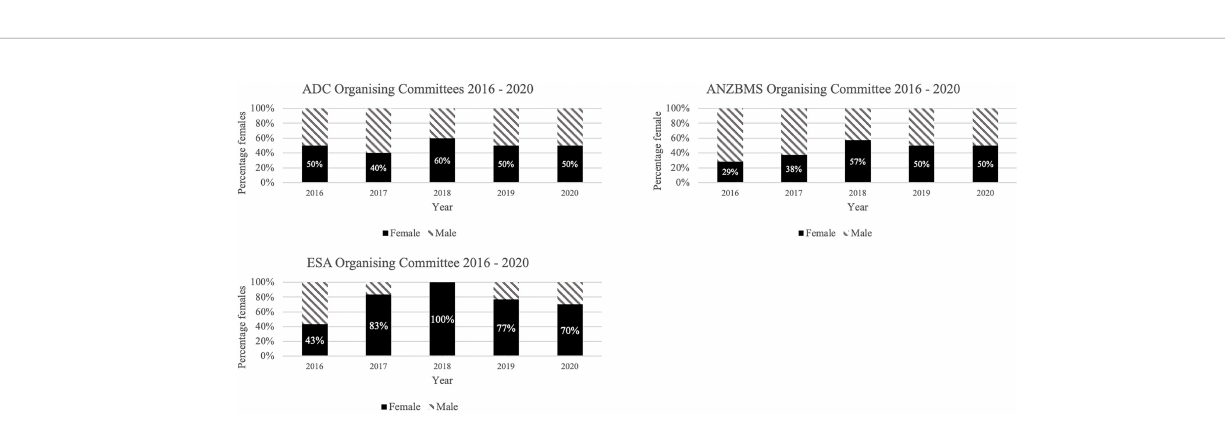
FIGURE 3 | Proportion of conference organising committee by gender. ADC, Australasian Diabetes Congress; ANZBMS, Australian and New Zealand Bone and Mineral Society; ESA, Endocrine Society of